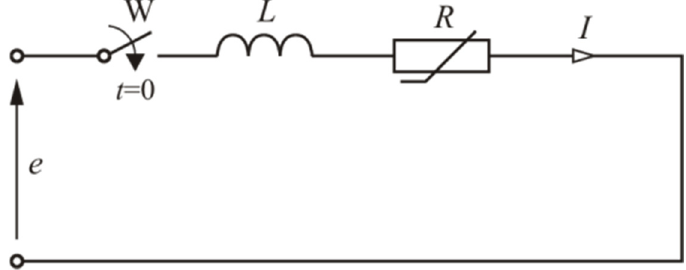
Figure 6. Replacement diagram of HTS transformer at core saturation.